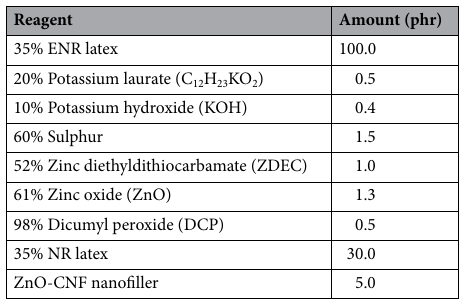
Table 5. Compound formulation for SH Glove